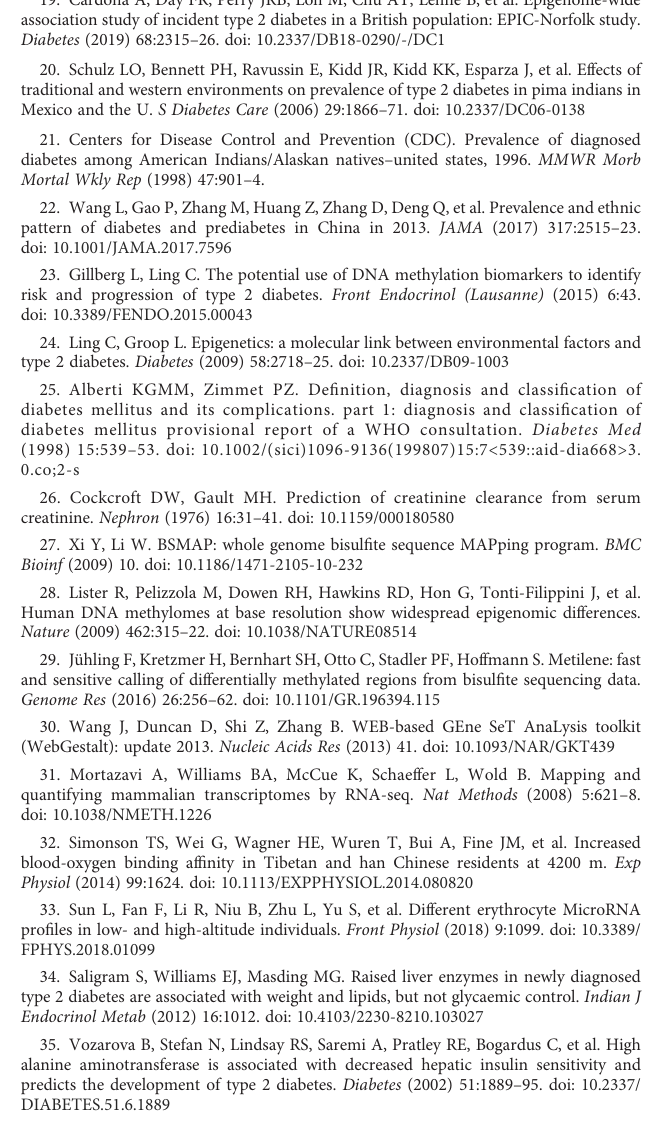
SUPPLEMENTARY FIGURE 1 The proportion of different types of methylated cytosines in 12 samples In the pie chart,red, greenand blueindicate mCG,mCHHand mCHG, respectively.H: Han, Z: Tibetan